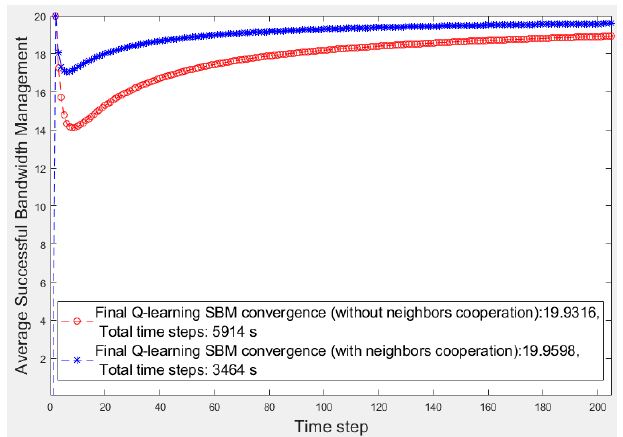
Figure 5. First 200 s of the average successful bandwidth management ( SBM ) of a three-fragment smart city network without and with fragment cooperation.